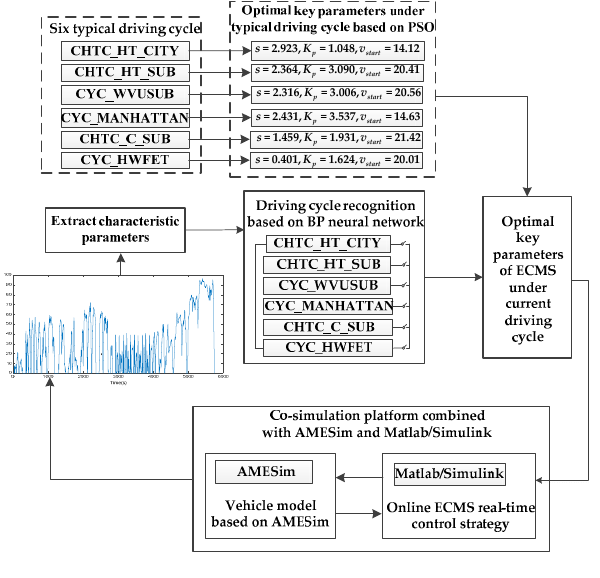
Figure 19. The principle of proposed A-ECMS. Table 6. Three kinds of optimal parameters for ECMS under six typical driving cycles. Typical Driving